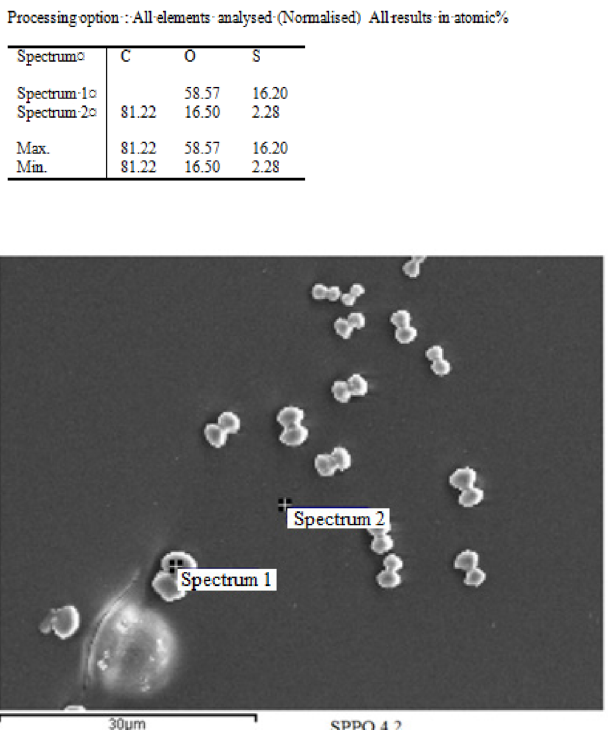
Figure 7. SEM images of SPPQ with 4.2 % S with the results of the analysis of the sulfur content in various parts of the film.